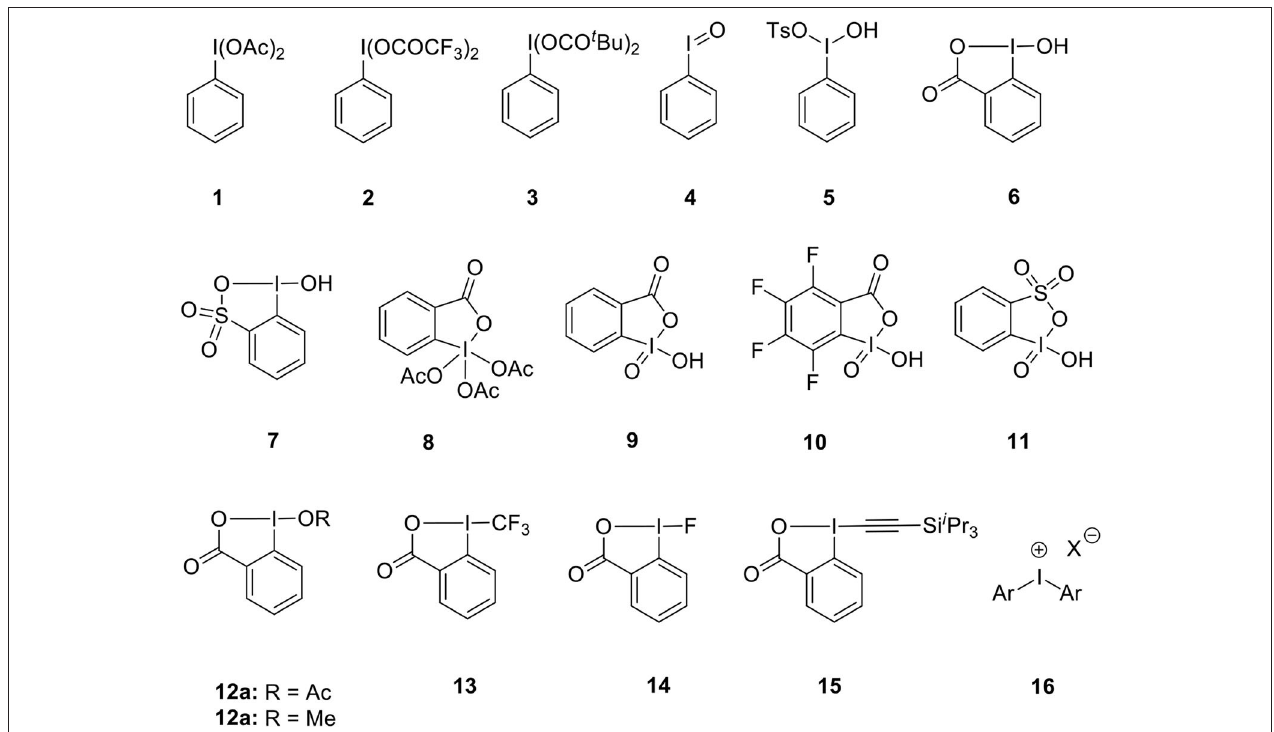
FIGURE 1 | Examples of hypervalent iodine(III)/(V) reagents 1–16